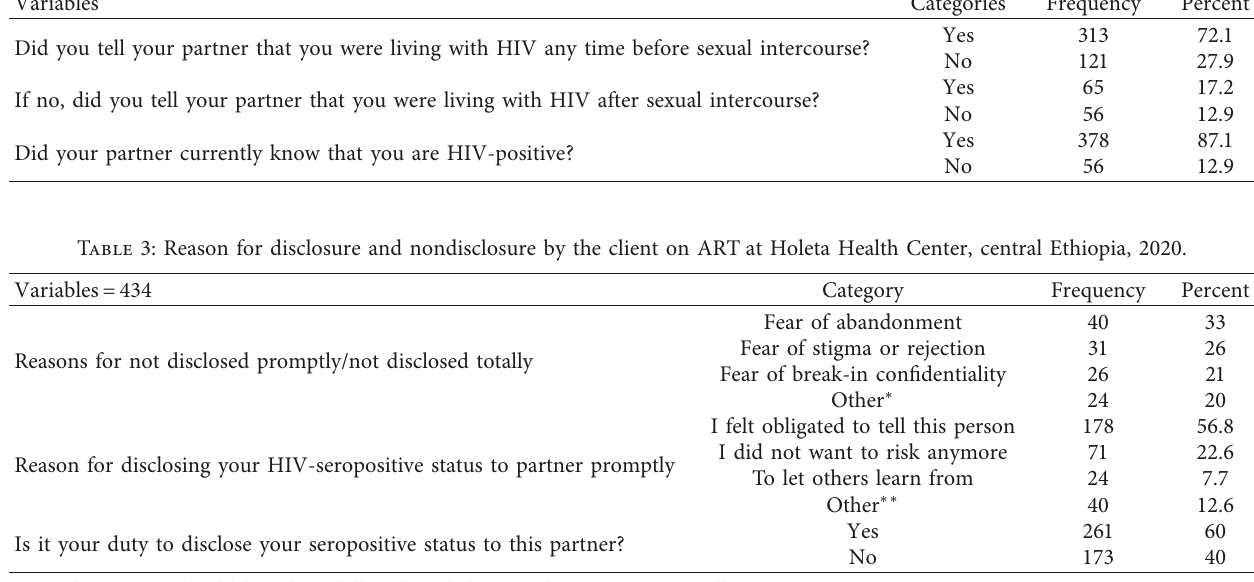
Table 2: Magnitude of prompt disclosure to partner among clients on ART at Holeta Health Center, central Ethiopia, 2020. Variables